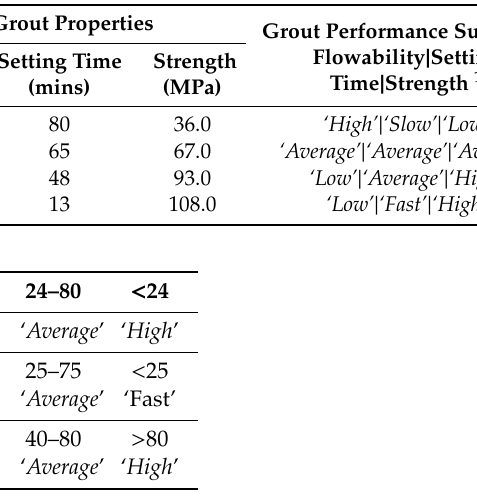
Table 4. Properties and composition of geopolymer grouts used for SFC pavement